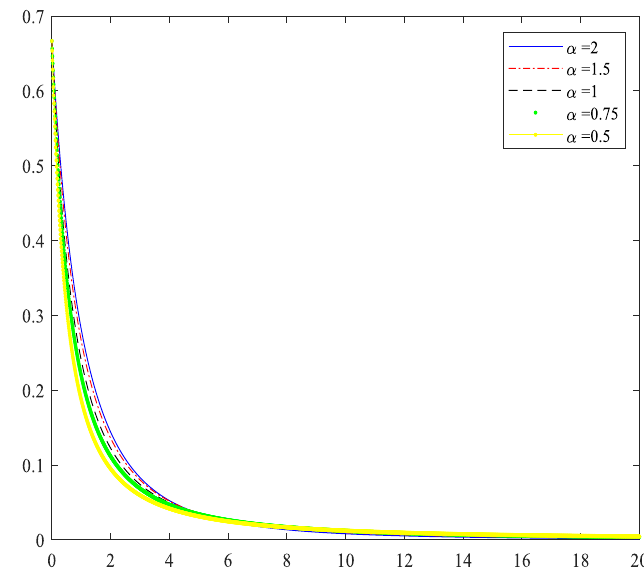
Figure 2. Comparison of α value in GPD PDF plots.